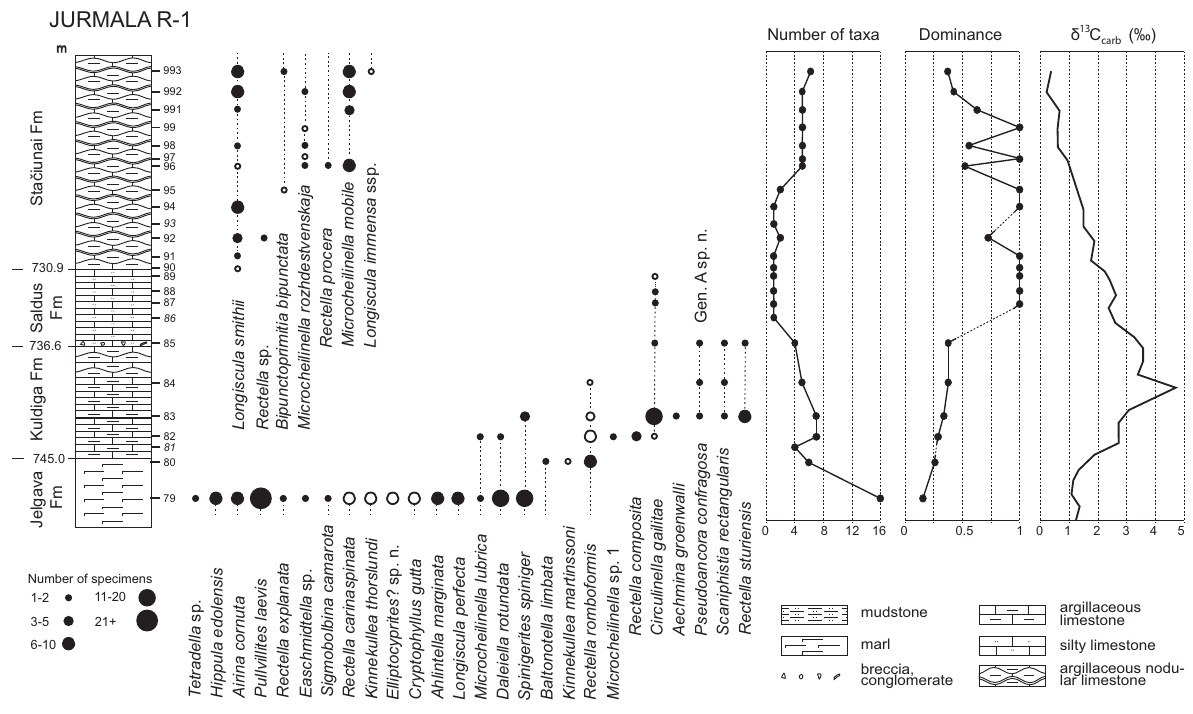
Fig. 3. Ostracod distribution in the Jūrmala core, species diversity and dominance, and the stable carbon isotopic curve after Ainsaar et al. (2010). Numbers of unfossiliferous samples (81, 86, 93) are indicated in italics, tentative occurrences are shown as empty circles. Extensions of species ranges into the Katian and upwards into the Silurian are based on the information on the stratigraphic ranges from previous publications (Gailīte et al. 1967; Pranskevičius 1971, 1972; Sarv & Meidla 1984; Meidla